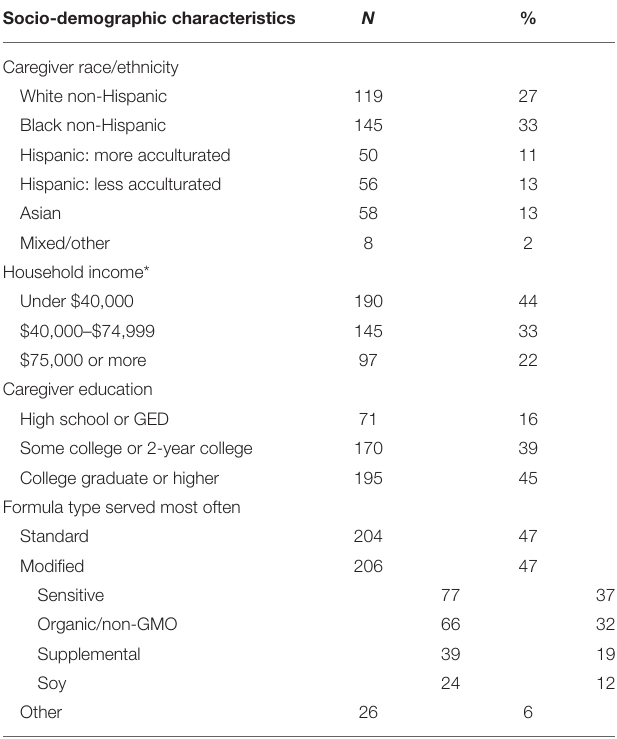
TABLE 1 | Participant characteristics ( N =